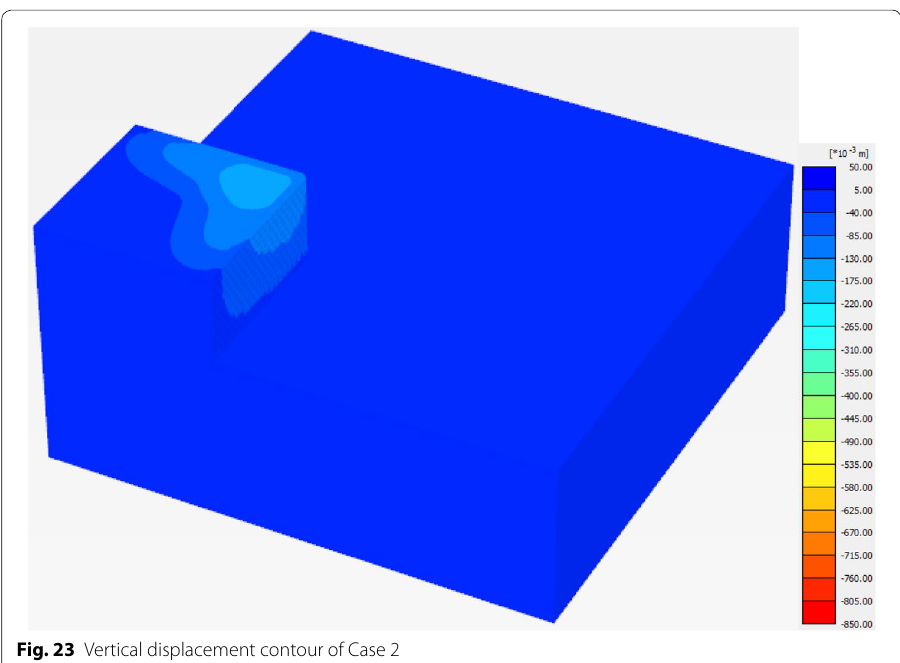
Fig. 23 Vertical displacement contour of Case 2